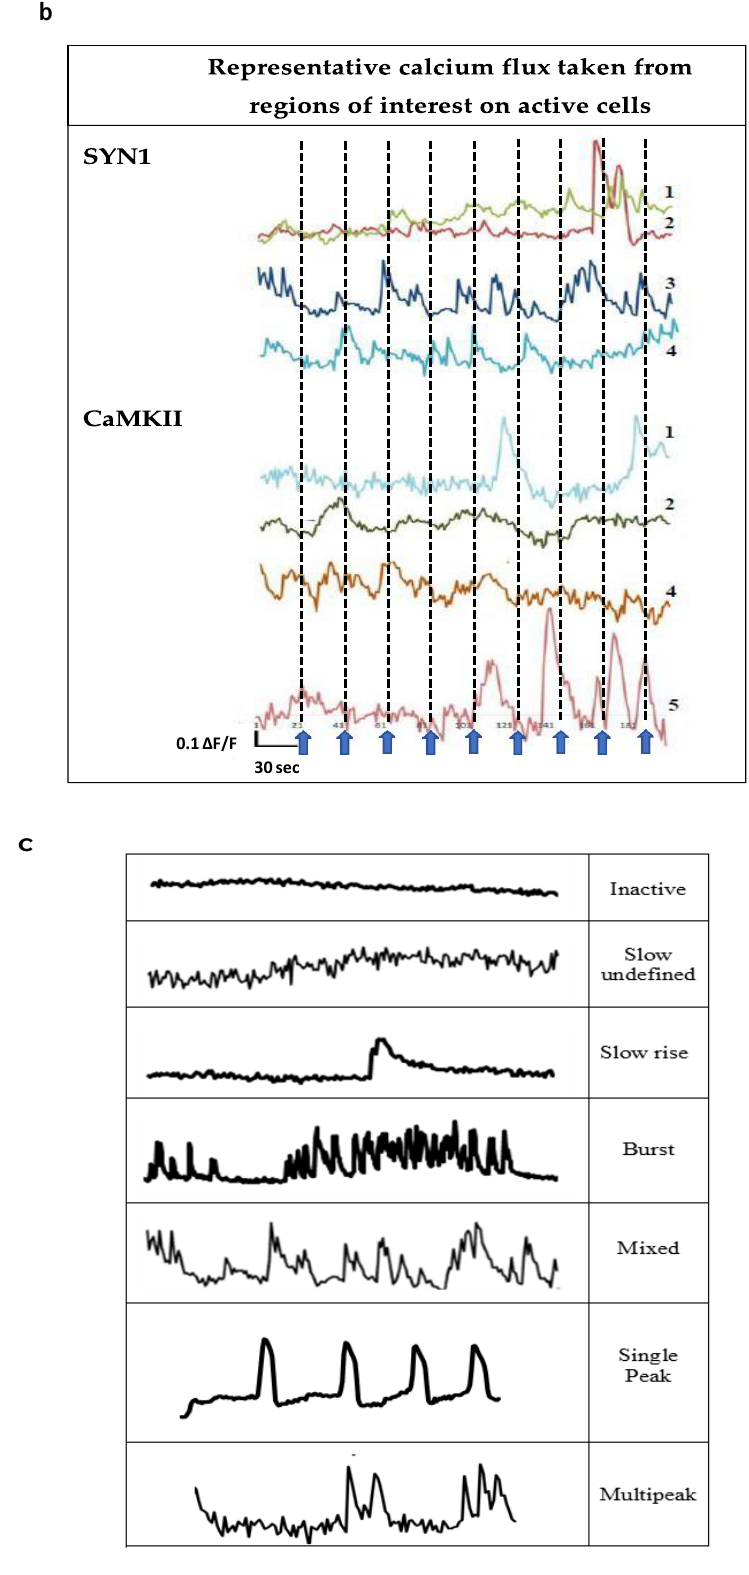
Figure 4. The neurons differentiated from human SH-SY5Y cells expressing ChR2-YFP, which were driven by SYN1 and CaMKII are responsive to optical stimulation. ( a ) The cells were stained with